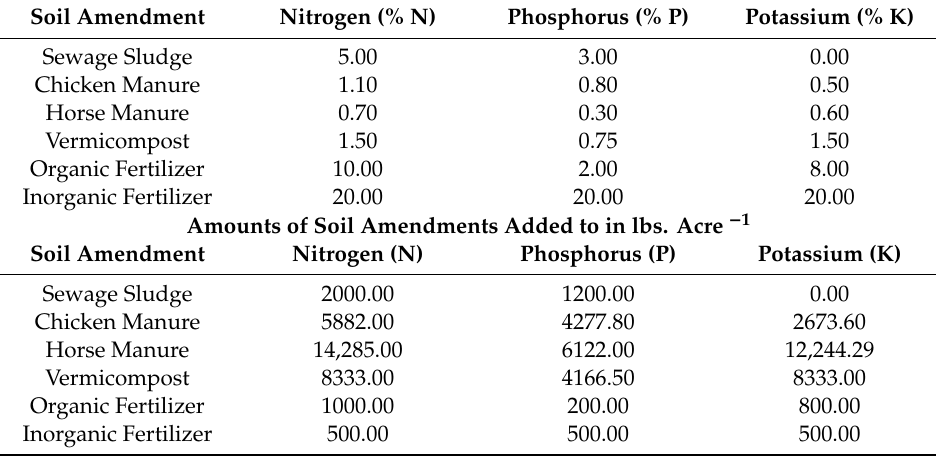
Table 1. Nitrogen, phosphorus, and potassium in soil amendments and amounts of nitrogen used for growing tomato plants in Fayette County, Kentucky,